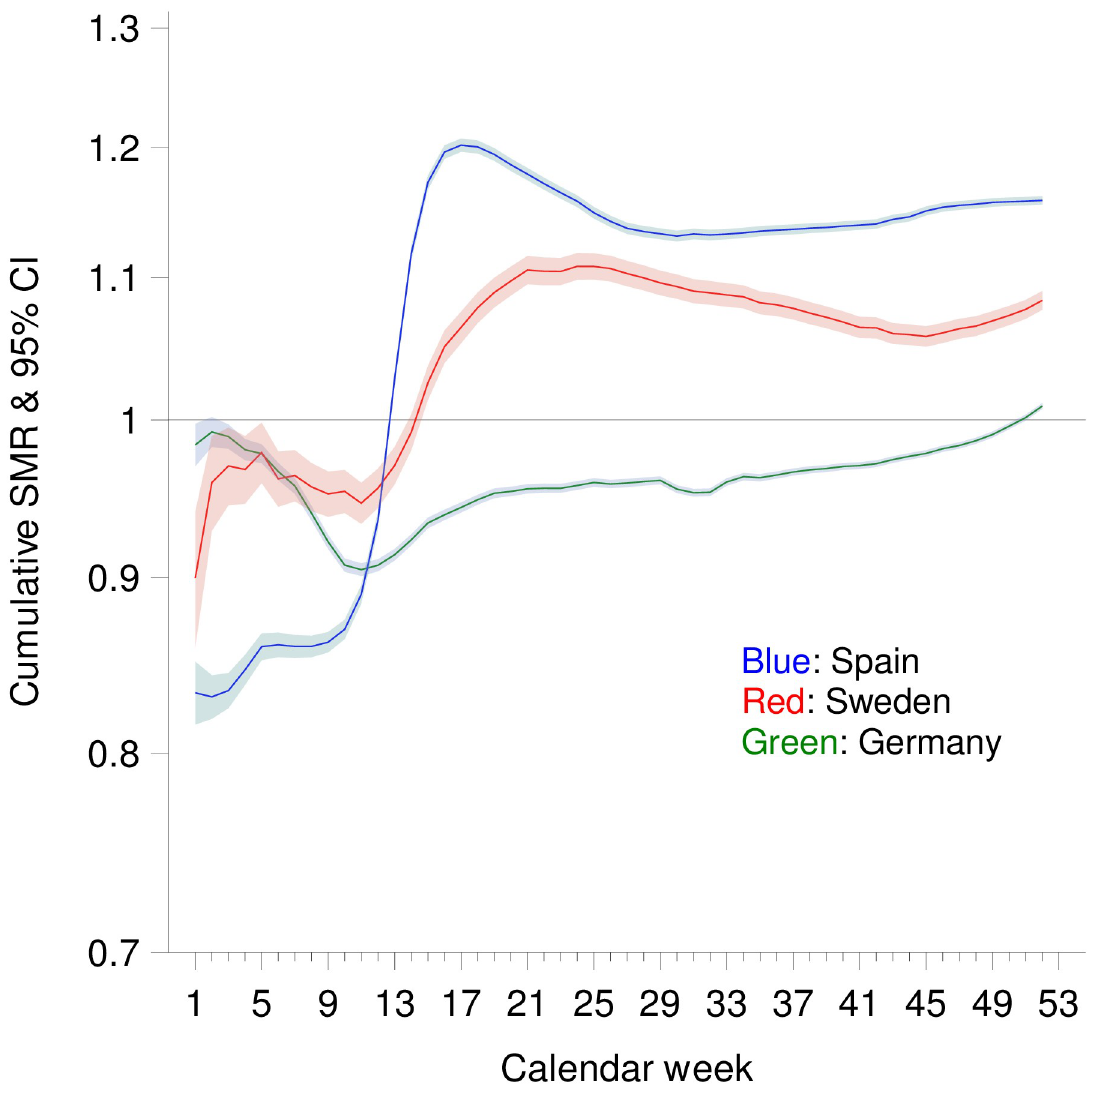
Fig 4. Cumulative standardized mortality ratio (SMR) by calendar week in Spain, Germany and Sweden (with consideration of life expectancy).